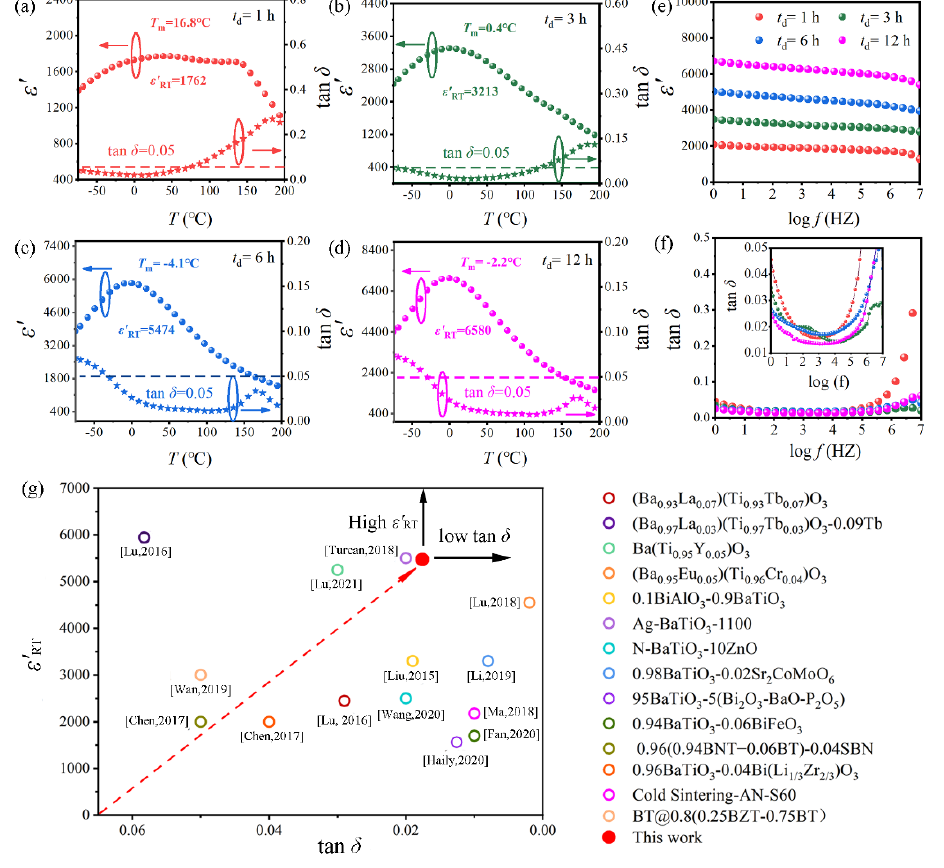
Figure 5. Temperature dependence of the dielectric constant ( ε′ ) and dielectric loss (tan δ ) measured at 1 kHz for BGTH7 ceramics sintered at T s = 1400 °C for different t d . ( a ) t d = 1 h, ( b ) t d = 3 h, ( c ) t d = 6 h, ( d ) t d = 12 h. The frequency dependence of the dielectric constant ( ε′ ) and dielectric loss (tan δ ) was measured at room temperature for BGTH7 ceramics sintered at T s = 1400 °C for different t d ( e ) and ( f ). ( g ) The dielectric properties of this work are compared with those of previously reported BaTiO 3 -based dielectric ceramics with X7U specifications [2,44 – 55]. ε (cid:48) and tan δ of BGTH7 ceramics sintered at 1400 ◦ C with different t d exhibited the same changes with frequency (Figure 5e,f). The value of ε (cid:48) in the high frequency region is lower than the low frequency region. The variation in ε (cid:48) with frequency can be